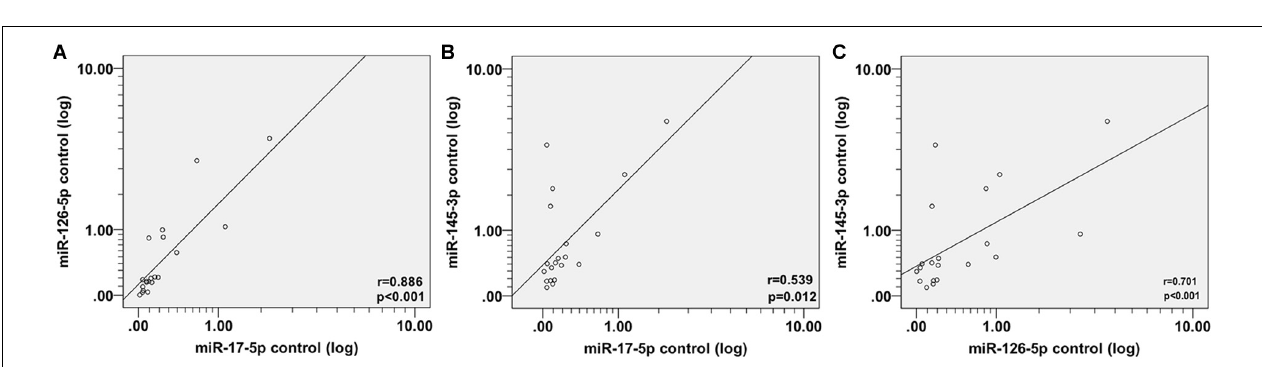
FIGURE 2 | Spearman correlations between the circulating miRNAs in patients with AMI before and after PCI. The scatter plots show the marked correlation in the expression values between (A) miR-17-5p before PCI and miR-126-5p before PCI, (B) miR-145-3p before PCI, (C) between miR-126-5p before PCI and miR-145-3p before PCI, (D) between miR-17-5p after PCI and miR-126-5p after PCI, (E) miR-145-3p after PCI, and (F) between miR-126-5p-after PCI and miR-145-3p-after PCI, in the population ( n = 29) with AMI.